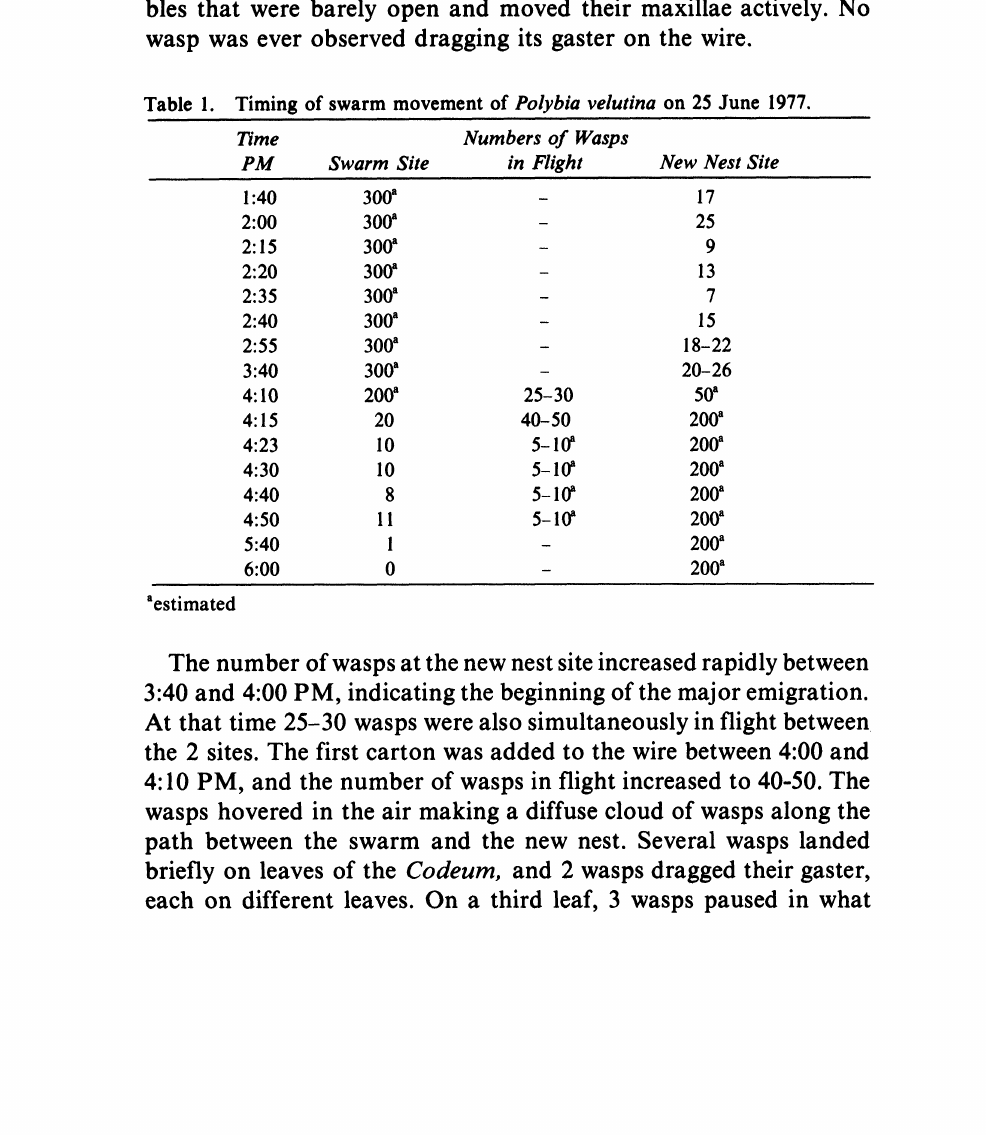
Table 1. Timing of swarm movement of Polybia velutina on 25 June